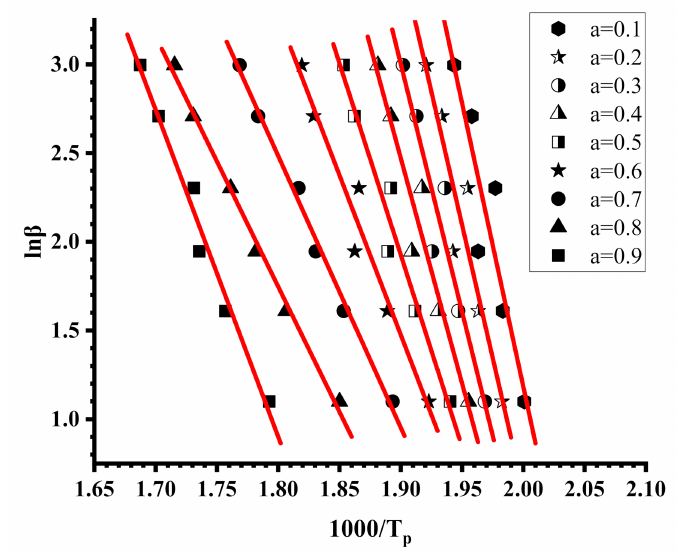
Figure 9. OFW plots for PIBMA.